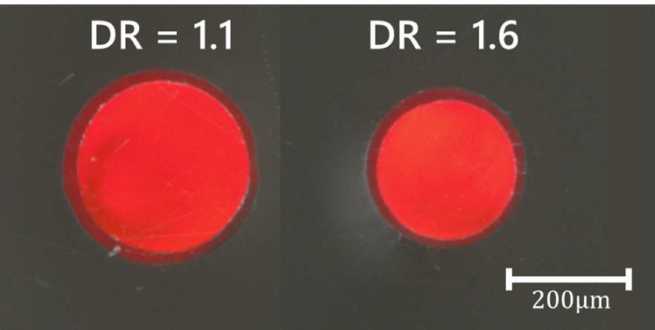
Figure 4. Microscopic cross-sections of core/sheath PL-POFs (DR = 1.1 and DR = 1.6) with doped COP core and pure THVP sheath.